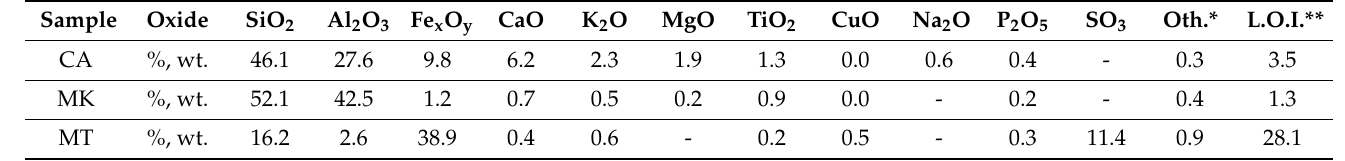
Table 1. Oxide composition of raw materials, coal ash (CA), metakaolin (MK) and mine tailings (MT).